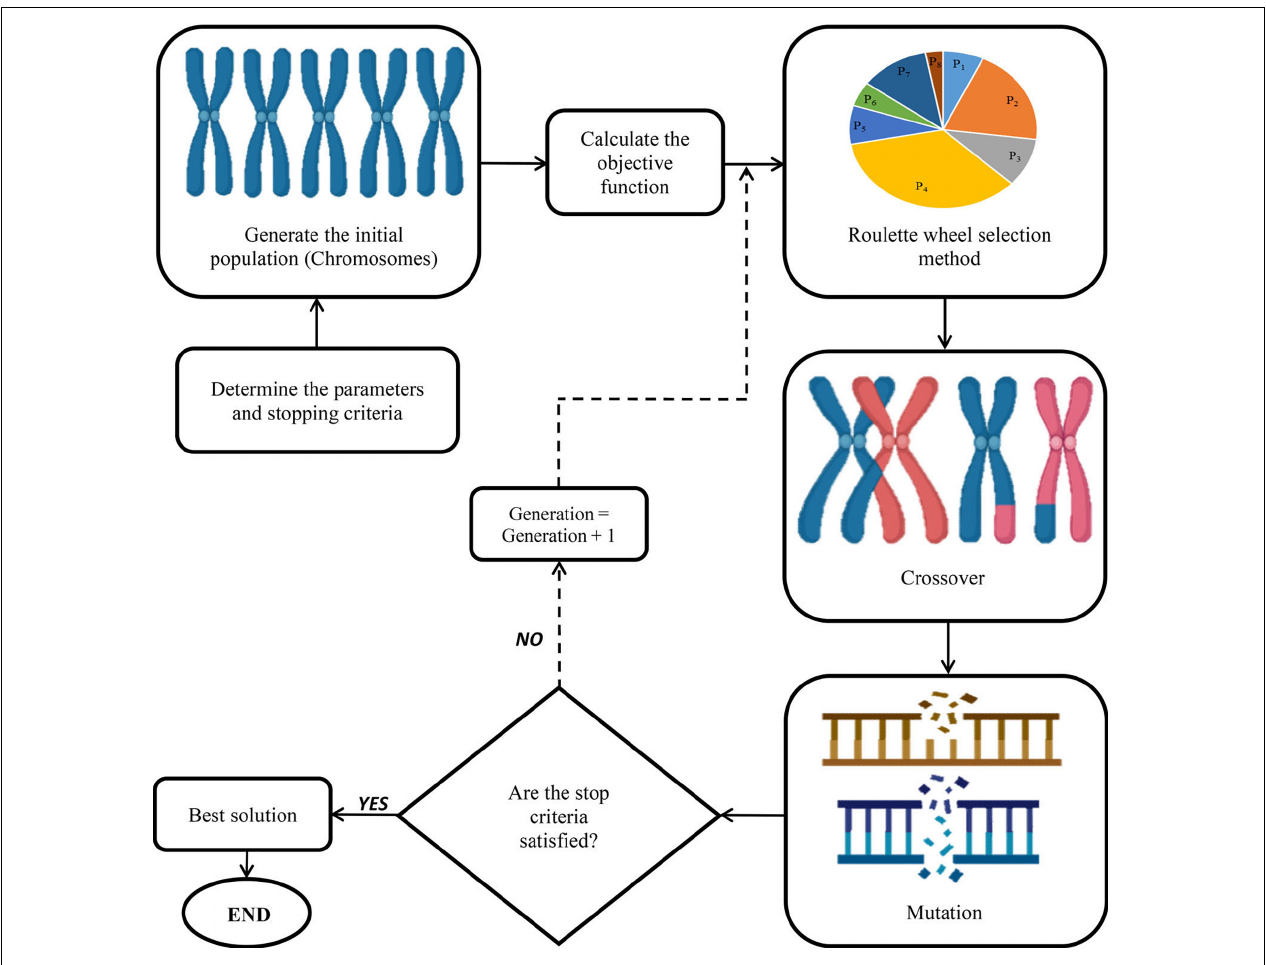
FIGURE 9 | A schematic representation of genetic algorithm